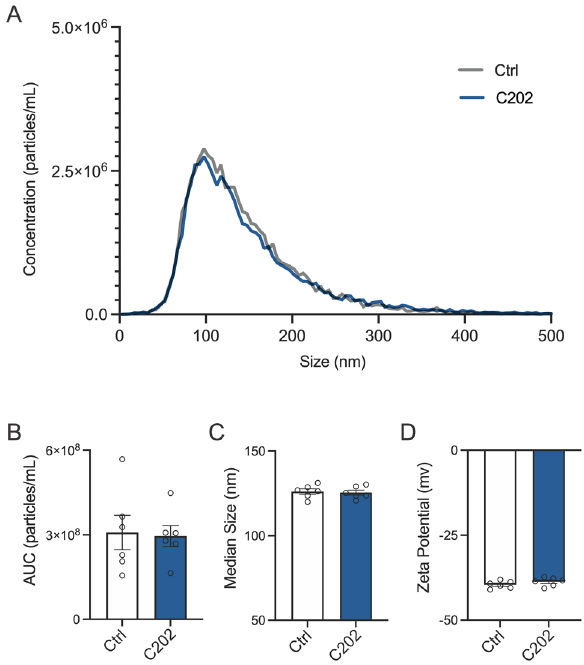
Figure 2. CD63-HA expression does not alter the secretion, size, or surface charge of DC2 epididymal epithelial cell extracellular vesicles (EVs). ( A ) Plots of the size distribution of EVs isolated from Ctrl and C202 DC2 conditioned media by ultracentrifugation overlap with identical single Gaussian peaks of 99.5 nm. ( B ) Area under the curve (AUC) analysis of the size distribution confirms no statistical difference in EV production between Ctrl and C202 cell lines. ( C,D ) ZetaView nanoparticle tracking also confirmed EVs secreted by Ctrl and C202 DC2 cells are indistinguishable based on median size ( C ) or surface charge (zeta potential). N = 6 samples isolated from conditioned media collected from distinct cell cultures. Data are mean ± SEM. Group means were assessed by student’s t-test, α =